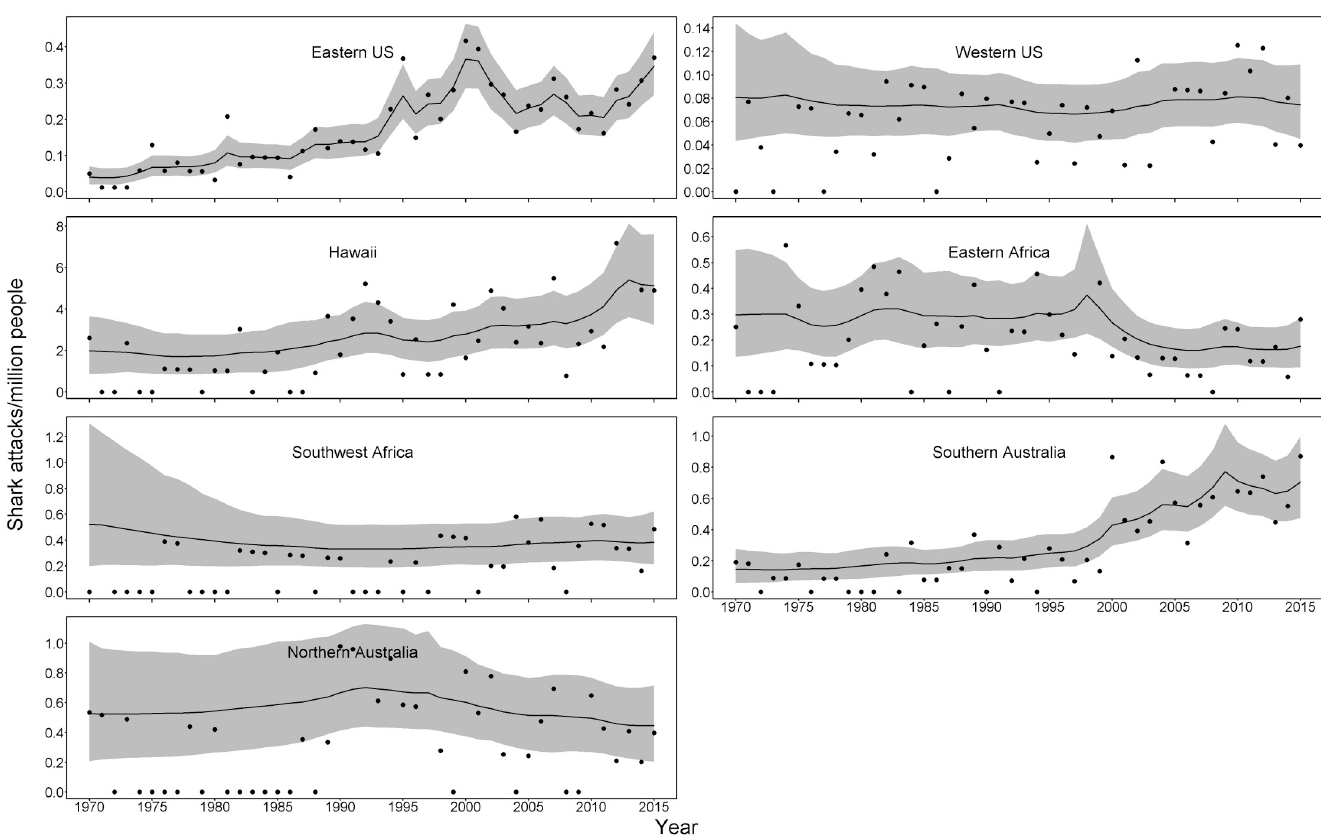
Fig 4. Shark attack rate (attacks per million people) from 1970–2015 for 7 regions in countries with the most attacks during this time. Black dots indicate annual rates, the black line represents the temporal trend, and the gray region indicates uncertainty (95% credible region) around the trend.